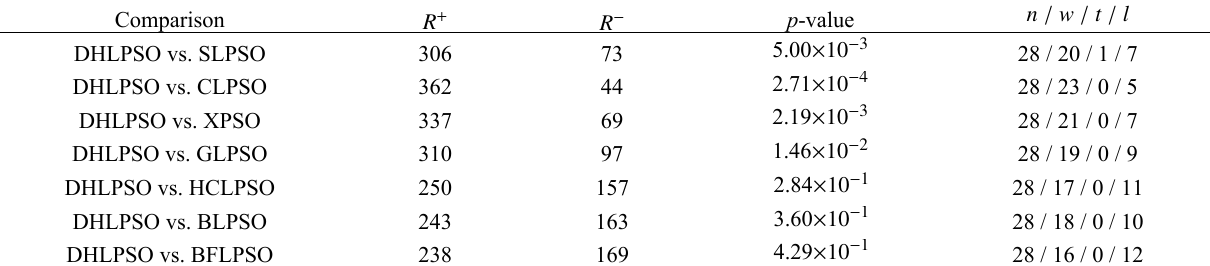
Table 3 Nonparametric test results from Table A2 in the Appendix.